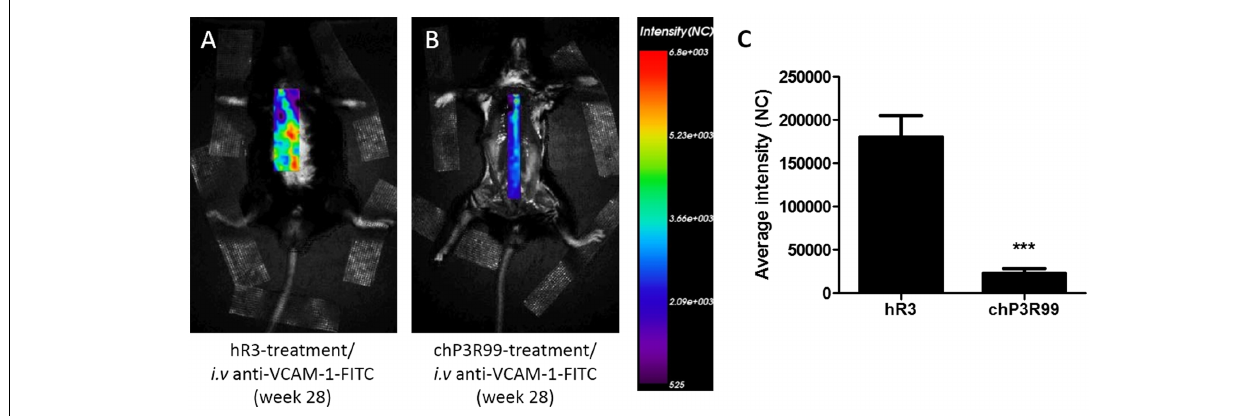
FIGURE 5 | In vivo localization of anti-VCAM-1 mAb coupled to FITC in 28-week-old apoE − / − mice. At the end of the administration protocol, mice received an i.v. injection of anti-VCAM-1-FITC mAb (10 µ g) and were scanned before (for autofluorescence background detection) and 3 days after anti-VCAM-1-FITC administration by optical imager Optix MX3 System. (A) Representative scan of a mouse from hR3-treated group. (B) Representative scan of a mouse from chP3R99-treated group. (C) Bar graph representing mean intensity expressed in normalized counts (NC) ± SEM ( n = 4 mice per group). ∗∗∗ represents p < 0.001 vs. isotype-matched hR3, unpaired student’s t